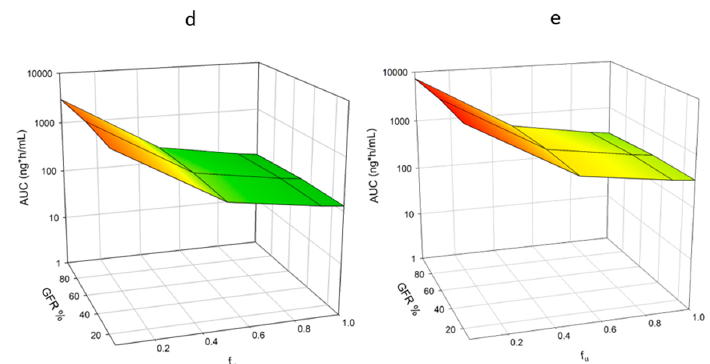
Figure 3. Impact of Fraction Unbound and Enzyme Expression on AUC of Nifedipine. Simulations were performed varying fraction unbound ( f u ) from the observed value for nifedipine (0.04) to 1.0. Expression of CYP3A4 was also varied ±2 ‐ and ±5 ‐ fold. A dose of 60 mg was administered orally to an exclusively male population in a fasted state. Simulations included ten trials with ten individuals in each. Age ranged from 21 to 65 years, and simulations were conducted with varying the degrees of RI by utilizing the following populations, Sim ‐ Healthy Volunteers, Sim ‐ RenalGFR_30 ‐ 60, and Sim ‐ RenalGFR_less_30 to represent 100%, 50% and 10% GFR. ( a ) Original CYP3A4 expression; ( b ) +2 ‐ fold CYP3A4 expression; ( c ) +5 ‐ fold CYP3A4 expression; ( d ) − 2 ‐ fold CYP3A4 expression; ( e ) − 5 ‐ fold CYP3A4 expression.